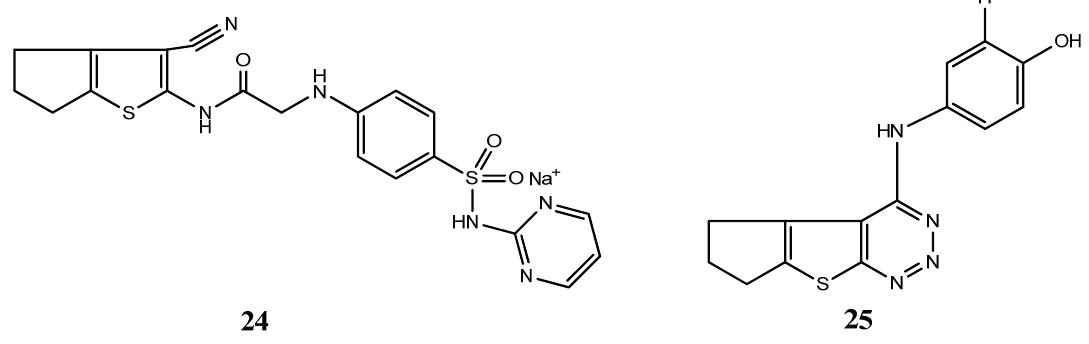
Figure 14. Chemical structure representation of N -(3- cyano-5,6-dihydro-4 H -cyclopenta ( b ) thiophene active derivatives, N -(3-Cyano-5,6-dihydro-4 H -cyclopenta[ b ]thiophen-2-yl)-2- (4-( N -(pyrimidin-2yl) sulfamoyl,sodiumsalt) phenylamino) acetamide ( 24 ) and 4-(5,6-dihydro- 7 H -cyclopenta (4:5) thieno (2,3- d )-1,2,3-triazin-4-ylamino)phenol ( 25 ) with